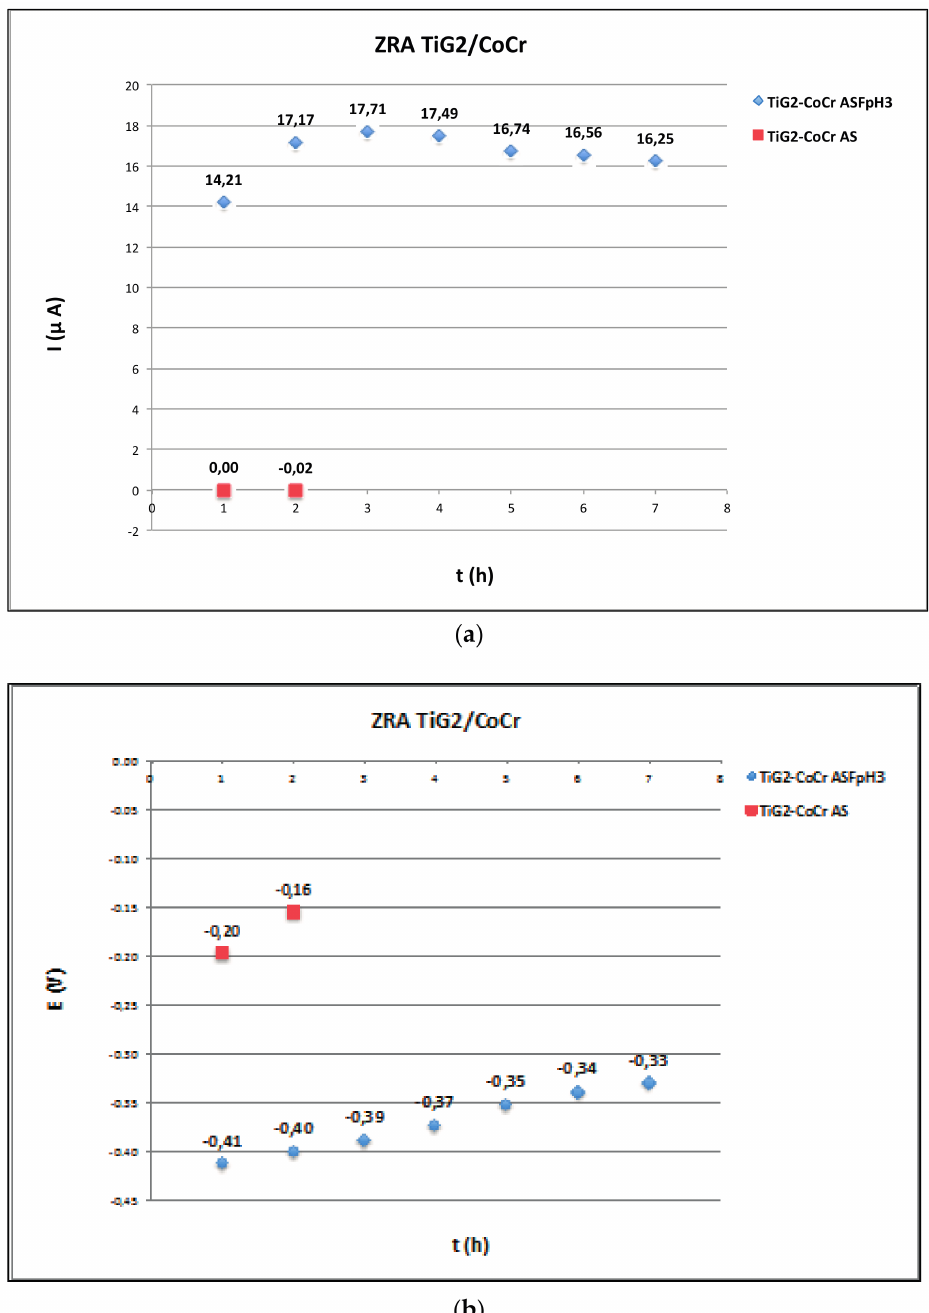
Figure 4. Average values at the end of every hour of immersion of the ( a ) galvanic current and ( b ) galvanic potential of the TiG2/CoCr pair in AS and ASF − pH3 as a function of